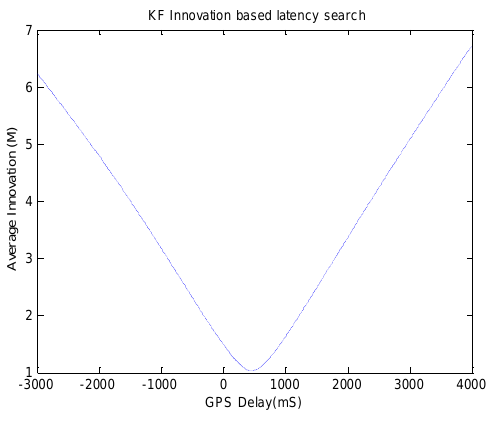
Figure 5 - KF innovation based latency search.